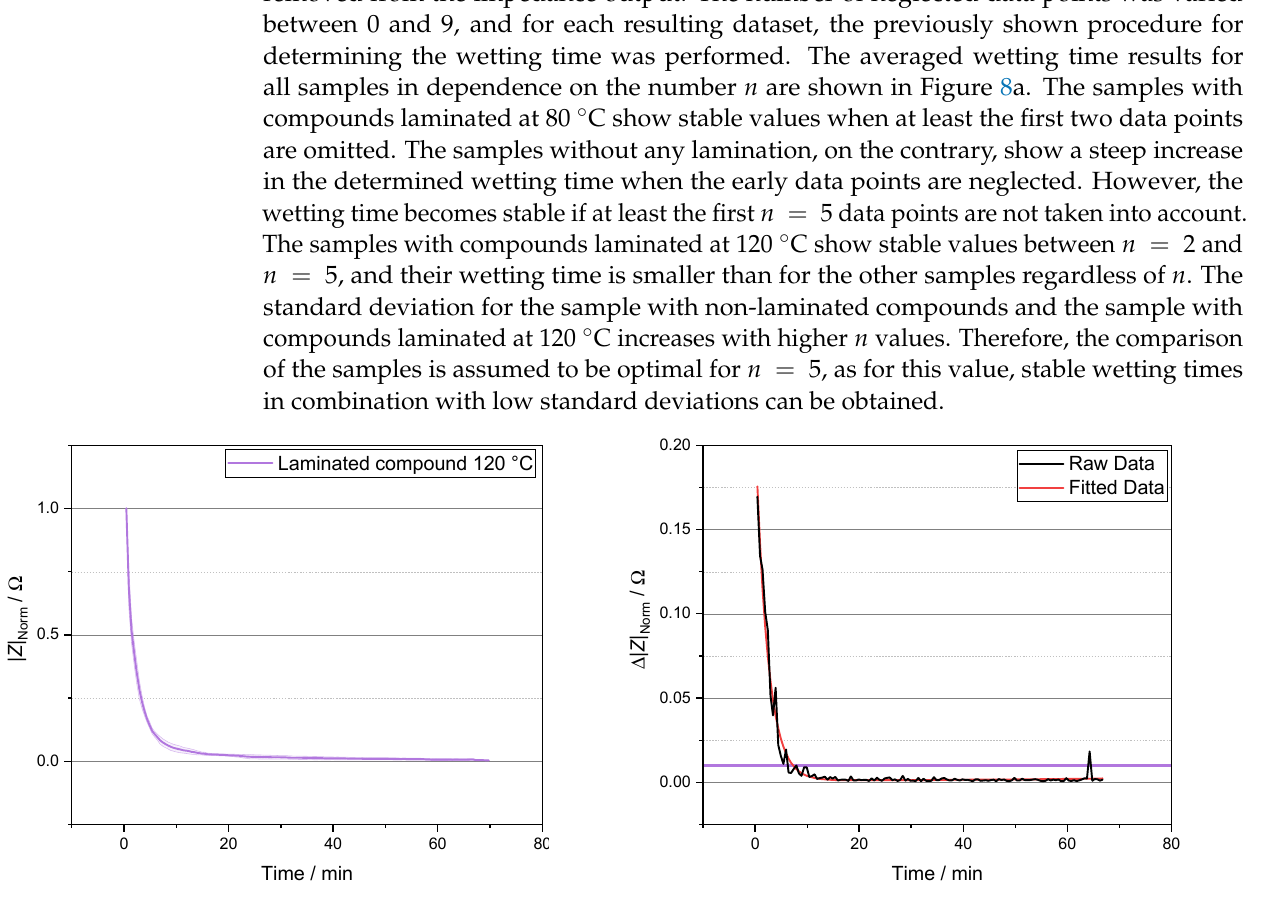
Figure 7. Average of the normalized modulus |𝑍| of the samples laminated at 120 °C ( a ). Absolute value of the first numerical derivation of the normalized modulus for one sample laminated at 120 °C and the respective analytical fit ( b ). The used standardization is mandatory for comparing the results of diverse samples.